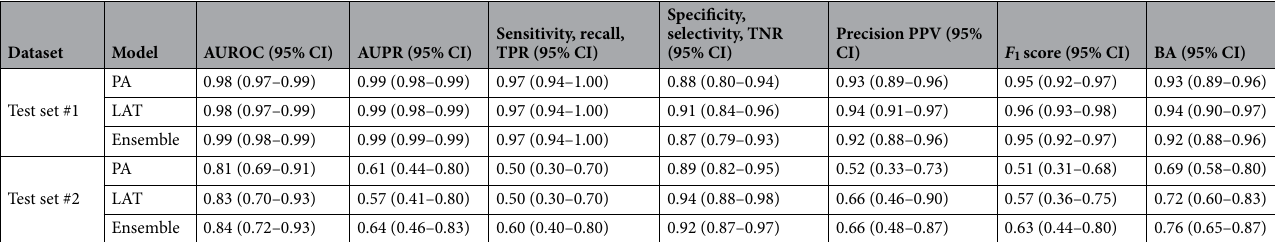
Table 2. DeepWrist’s performance on trivial cases (test set #1) and hard cases ( test set #2). Here, AUROC is area under the receiver operating characteristic, AUPR is the area under precision recall curve, CI is